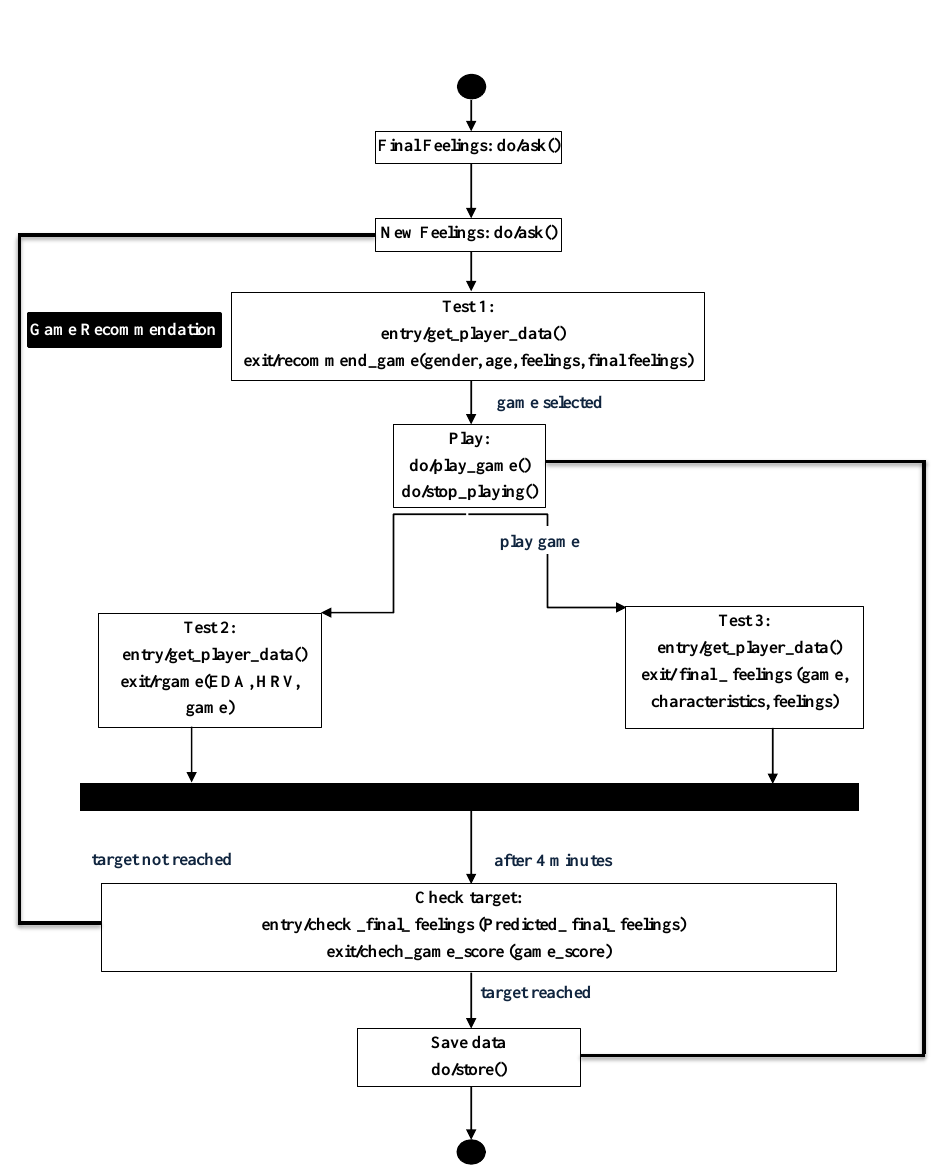
Figure 3. Algorithm for the recommendation